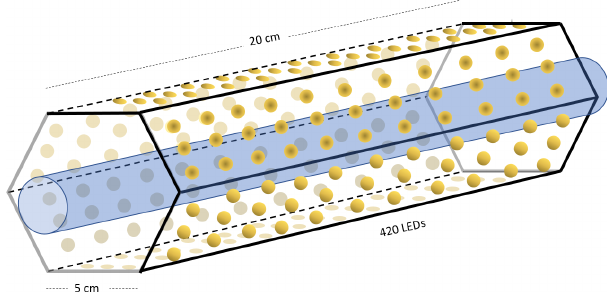
Figure B2. Hexagonal photochemical device consisting of con- nected circuit boards of 420 LEDs at